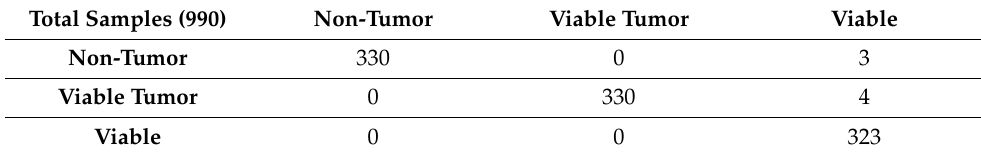
Table 4. Testing confusion matrix of ADAM empowered with transfer learning. Total Samples